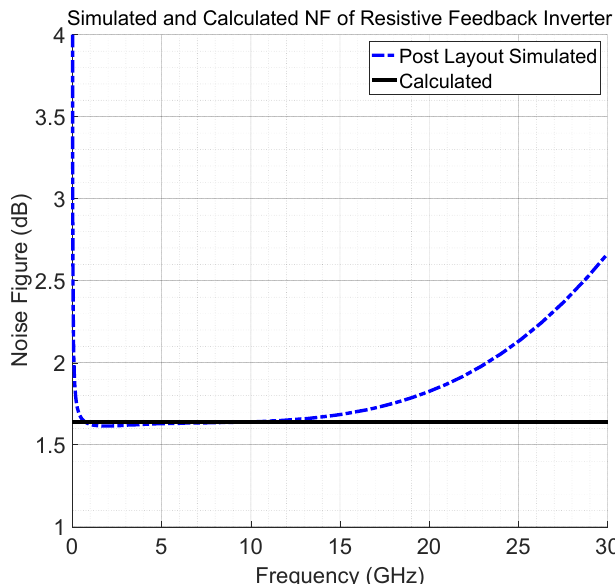
Figure 3. Calculated and simulated NF of